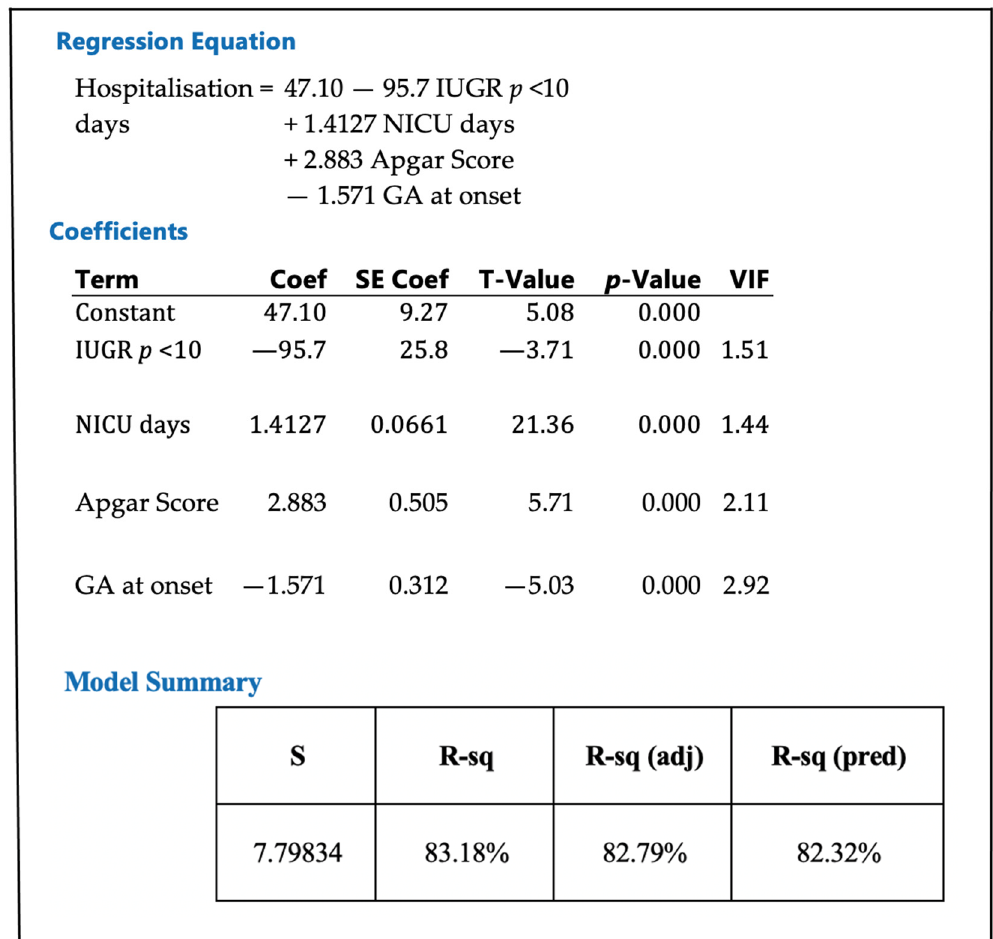
Figure 3. The relationship between hospitalization days and newborn percentile less than percentile 10 (IUGR p < 10), neonatal intensive care unit (NICU) days, Apgar score, and gestational age (GA) at delivery; data analyzed using Pearson correlation, p < 0.001, R-sq = 83.18%.